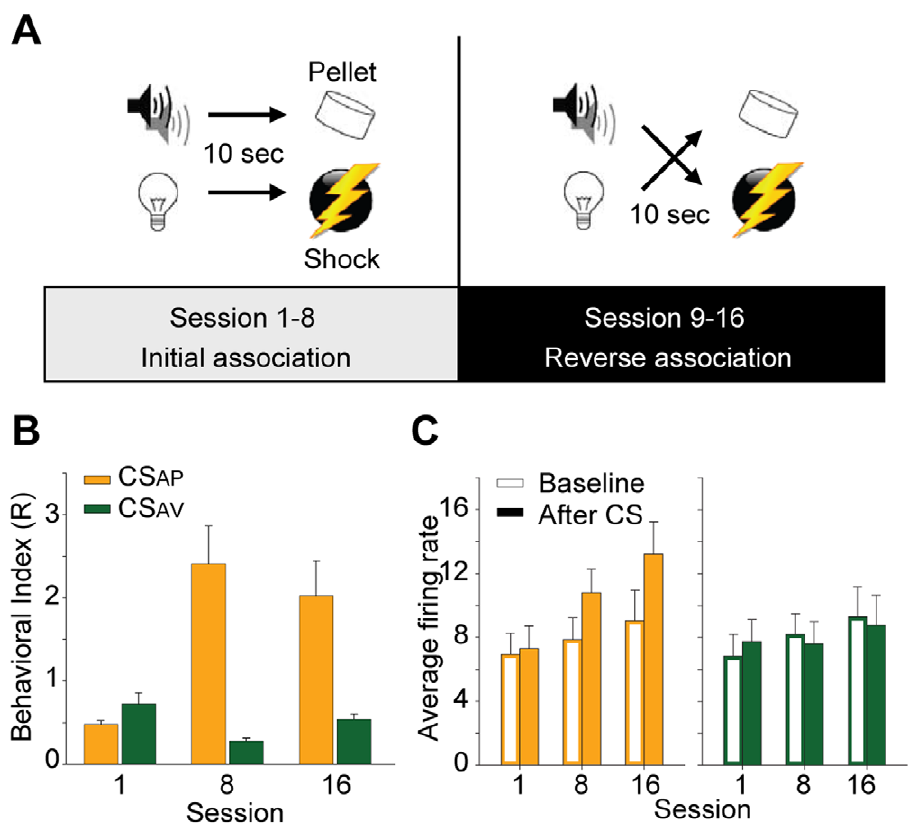
Figure 1. Task, behavior, and single unit activity. ( A ) Schematic representing the two conditioned associations in the initial segment of the task (left: sessions 1–8) and following the reversal of the initially conditioned associations (right: sessions 9–16). A tone or light CS was randomly presented for 10 sec and, upon termination of the stimulus, an aversive (mild electrical shock; 180 ms, 0.2 mA) or appetitive (sugar pellet 45 mg) outcome was delivered to the animal. Following 8 consecutive sessions of conditioning, these initial associations were reversed. ( B ) Behavioral performance. Data presented as mean + SEM. The behavioral index ( R ) is the ratio of nose pokes in the food trough during either CS presentation (10 sec, 30 trials) relative to nose pokes in the food trough during the baseline period (10 sec, 60 trials). ( C ) Population activity of VTA units. Data presented as mean + SEM. Empty bars represent the pre-stimulus baseline window (0.5 sec: 2 1 to 2 0.5 sec), filled bars represent the stimulus delivery window (0.5 sec: 0 to 0.5 sec). Data are plotted separately for CS AP and CS AV (left and right, respectively). Note that in the first conditioning session (session 1), population responses during CS AP and CS AV presentation did not differ from baseline levels. In the final sessions of the initial association (session 8) and reversal sessions (session 16), VTA population responses increased during CS AP presentation and decreased during CS AV presentation. Note that there were no statistically significant differences of firing rates during baseline period across session.